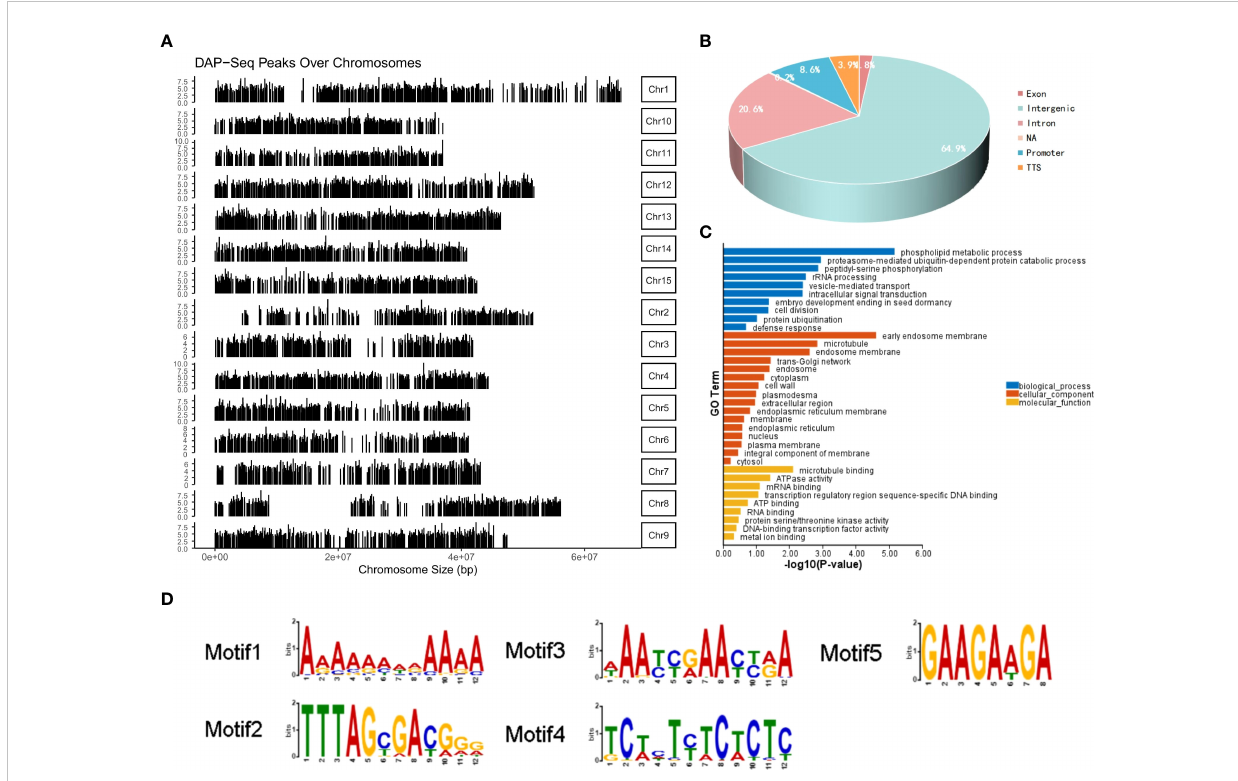
FIGURE 5 DAP-seq analysis of MeGI . (A) Distribution of the MeGI -binding sites along the D . oleifera chromosomes. (B) Distribution of the MeGI -binding sites in the genic and intergenic regions. (C) GO classi fi cation analysis of the MeGI -regulated target genes. (D) Nucleotide motifs recognized by MeGI in DAP-seq